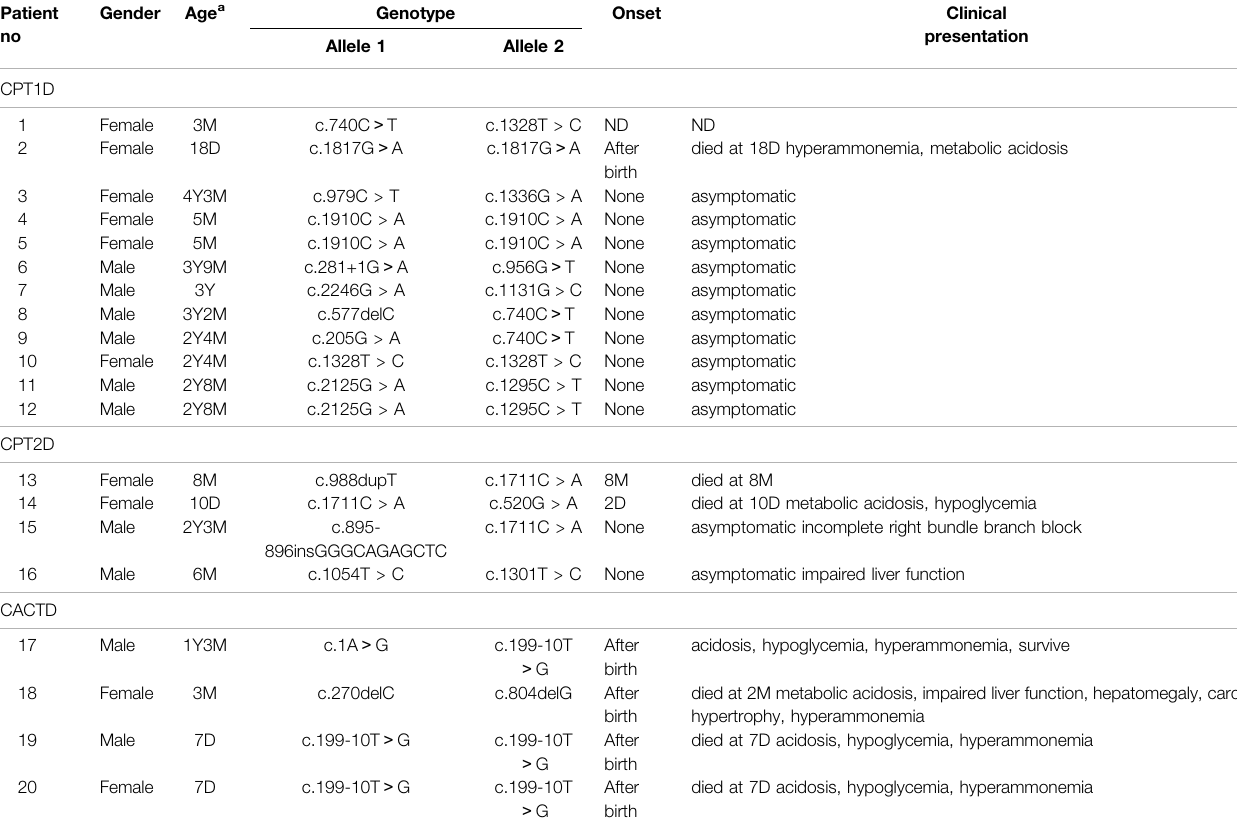
TABLE 2 | Clinical presentation, biochemical, and genetic investigation of con fi rmed patients with CPT1D, CPT2D, CACTD. Patient